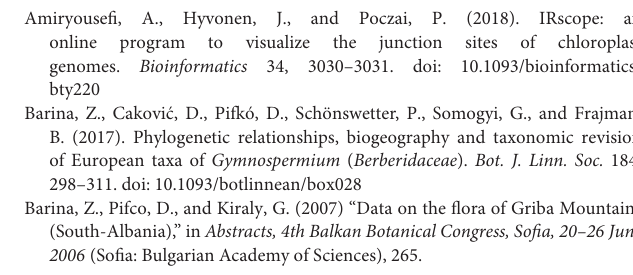
Supplementary Figure 1 | Comparison of the 26 plastomes of Nandinoideae analyzed in this study using mVISTA, with Ranzania japonica (MG234280) as a reference. Supplementary Figure 2 | MAUVE alignment of the 26 Nandinoideae plastomes analyzed in this study, with Gymnospermium albertii (I) as a reference. Supplementary Figure 3 | Maximum likelihood (ML) trees based on each of the 21 hotspot regions ( Pi > 0.02). (A) ycf 1; (B) trn T -trn L; (C) trn T -psb D; (D) rpl 32 -trn L; (E) trn H -psb A; (F) pet N -psb M; (G) trn K -rps 16; (H) ndh G -ndh I; (I) ndh F -rpl 32; (J) psb E -pet L; (K) ndh C -trn V; (L) rpl 22; (M) pet A -psb J; (N) trn P -psa J; (O) rps 15 -ycf 1; (P) rps 16 -trn Q; (Q) psb Z -trn G; (R) trn D -trn Y; (S) rps 8 -rpl 14; (T) psa C -ndh E; U, ndh E -ndh G. Numbers listed at each node represents bootstrap support (BS) values. The hyphen indicates BS <